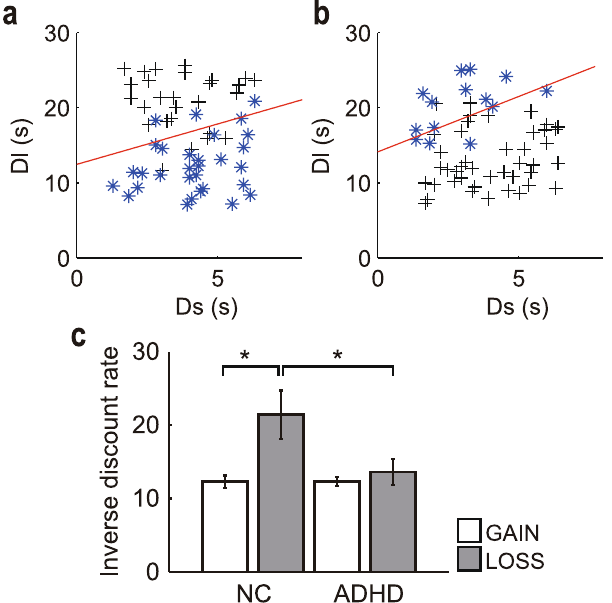
Figure 2. ( a ) Choice pattern of a representative participant (NC) in the GAIN condition and ( b ) the LOSS condition. The delay length of the larger-later option (D L ) was plotted against the delay length of the smaller- sooner option (D S ) for each choice. Asterisks ( * ) indicate selection of the larger-later option (yellow square: + 40 yen) and crosses ( + ) indicate selection of the smaller-sooner option (white square: + 10 yen). The lines indicate the estimated indifference line of the participant [intercept = 12.47 (GAIN), 14.13 (LOSS) for the